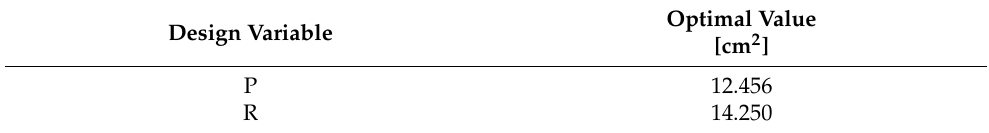
Table 8. Design variable values from deterministic